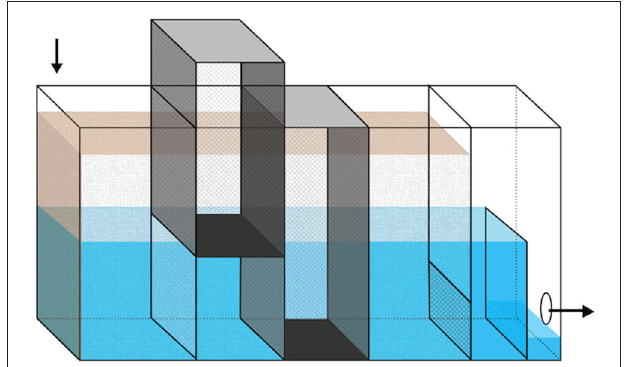
FIGURE 1 | Diagram of laboratory-scale bioreactor. The reactors are 13 × 46 × 30.5 cm, with the brown shading showing the woodchip bed and the blue/gray areas showing the water level. Arrows indicate the direction of flow. The darker rectangular prisms show the location of the two removable sampling ports, which allowed sampling of woodchips from approximately half (top port) and full (bottom port) depth of the woodchip bed. Water level was controlled by adjusting the height of the overflow weir, which is shown here at low height, immediately before the effluent hole on the right side of the